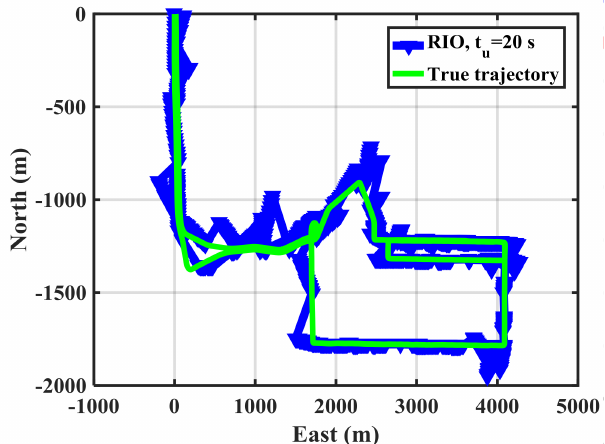
Figure 13. Mean trajectory errors for various combinations of GPS and IMU sensors for different update intervals.